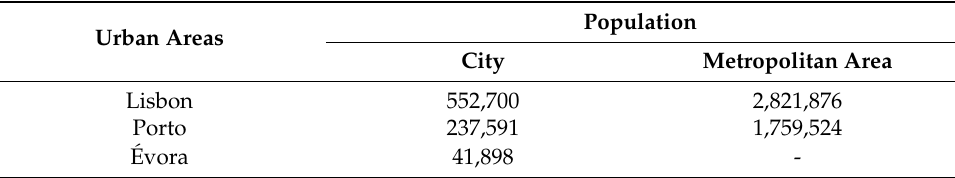
Table 1. Resident population in Lisbon, Porto and É vora